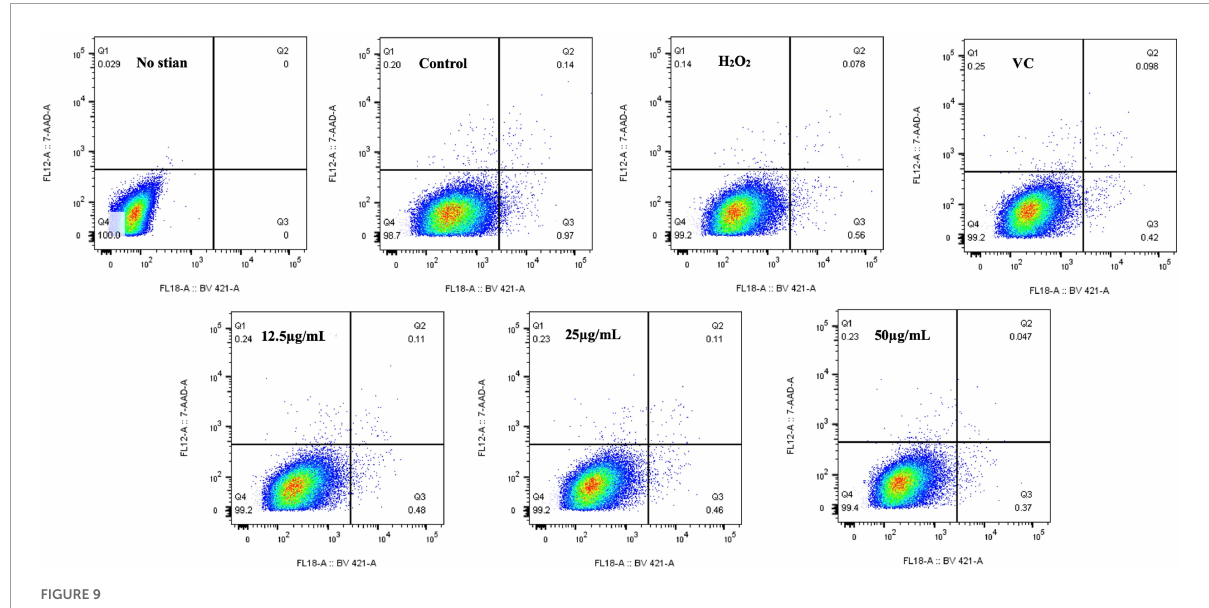
FIGURE9 Effect of EFP-2 on H 2 O 2 -induced apoptosis in RAW264.7 cells.